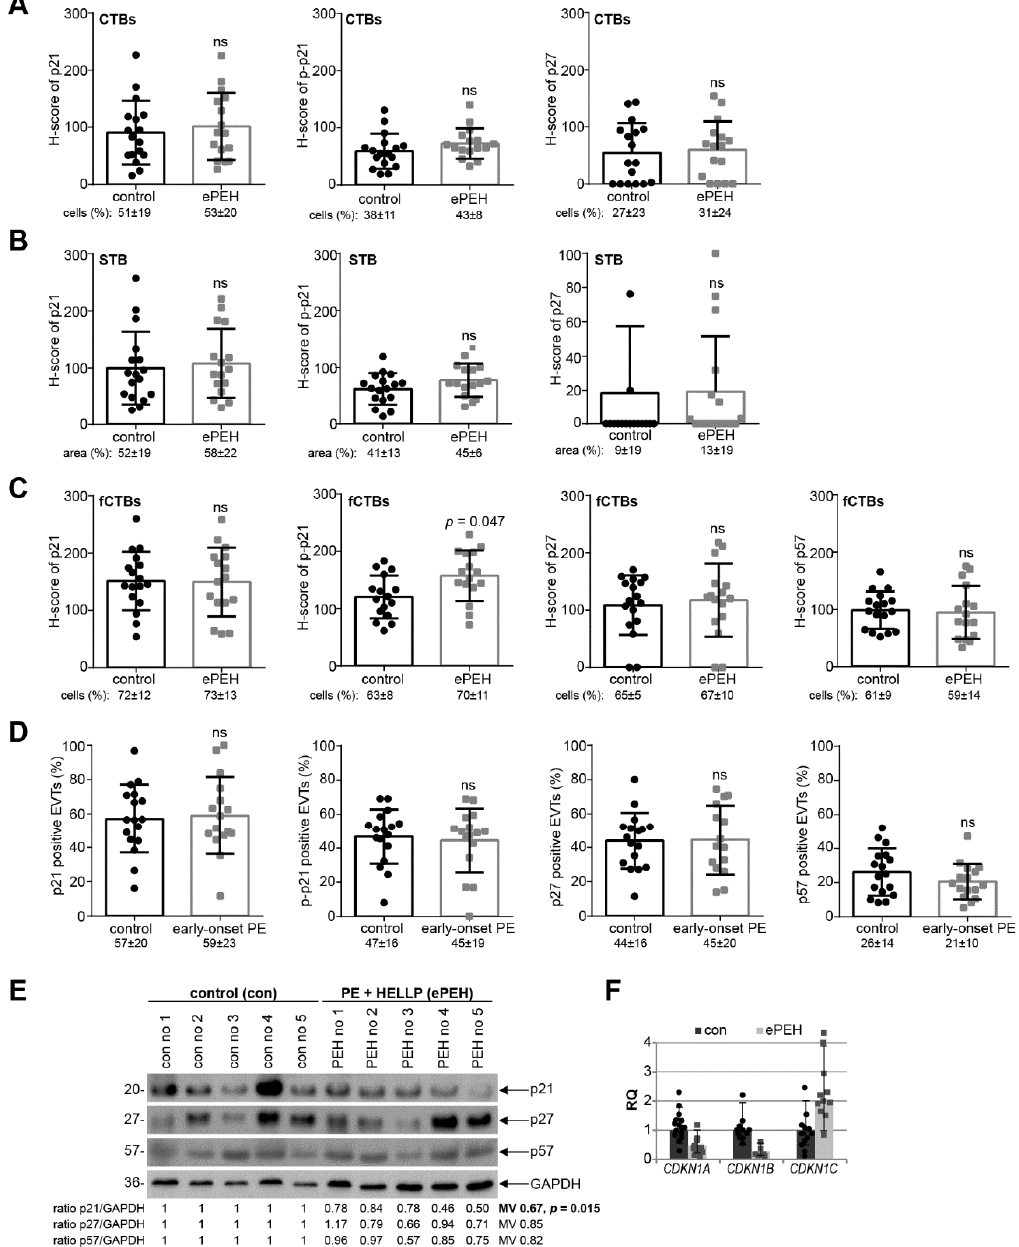
Figure 4. p21 expression is reduced in early-onset PE complicated by the HELLP syndrome. ( A – C ) Quantification of cell cycle regulators in placental sections of control donors (control, n = 17) and placental tissues from early-onset PE complicated by the HELLP syndrome (ePEH, n = 16) using the H-score method. The results are presented as bar and scatter plots showing the mean value with SD. The percentage of positive stained cells/area is shown under each graph. ( A ) H-score of p21 (left panel), p–p21 (middle panel), and p27 (right panel) for CTBs. ( B ) H-score of p21 (left panel), p–p21 (middle panel), and p27 (right panel) for the STB area. ( C ) H-score of p21 (left panel), p–p21 (second panel), p27 (third panel), and p57 (right panel) for fCTBs. ( D ) Quantification of p21 positive (left panel), p–p21 positive (second panel), p27 positive (third panel), and p57 positive EVTs (right panel) in %. ( E ) Western blot analysis with extracts from placental tissues is shown. GAPDH served as the loading control. ( F ) The relative amount of the gene levels of CDKN1A (p21), CDKN1B (p27) and CDKN1C (p57) was analyzed with placental tissues. The results are presented as relative quantification (RQ) with minimum and maximum range. TBP was used as the endogenous control. Paired Student’s t -test or Wilcoxon-test was used for statistical analysis. CTBs, cytotrophoblasts; fCTBs, cytotrophoblasts ongoing to fuse; STB, syncytiotrophoblast; EVT, extravillous cytotrophoblasts; no, number; MV, mean